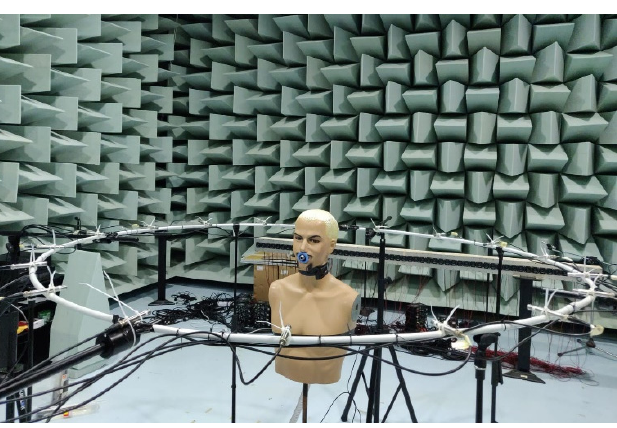
Figure 1. Experimental set-up with the microphone arrangement around the head and torso simulator housing the sound source nose in the mouth.